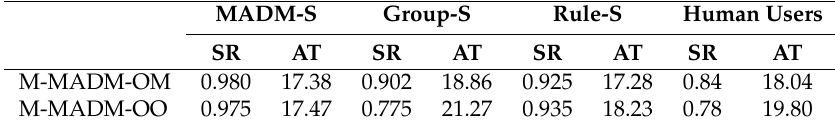
Table 6. Cross-model evaluation on Success Rate (SR) and Average Turns